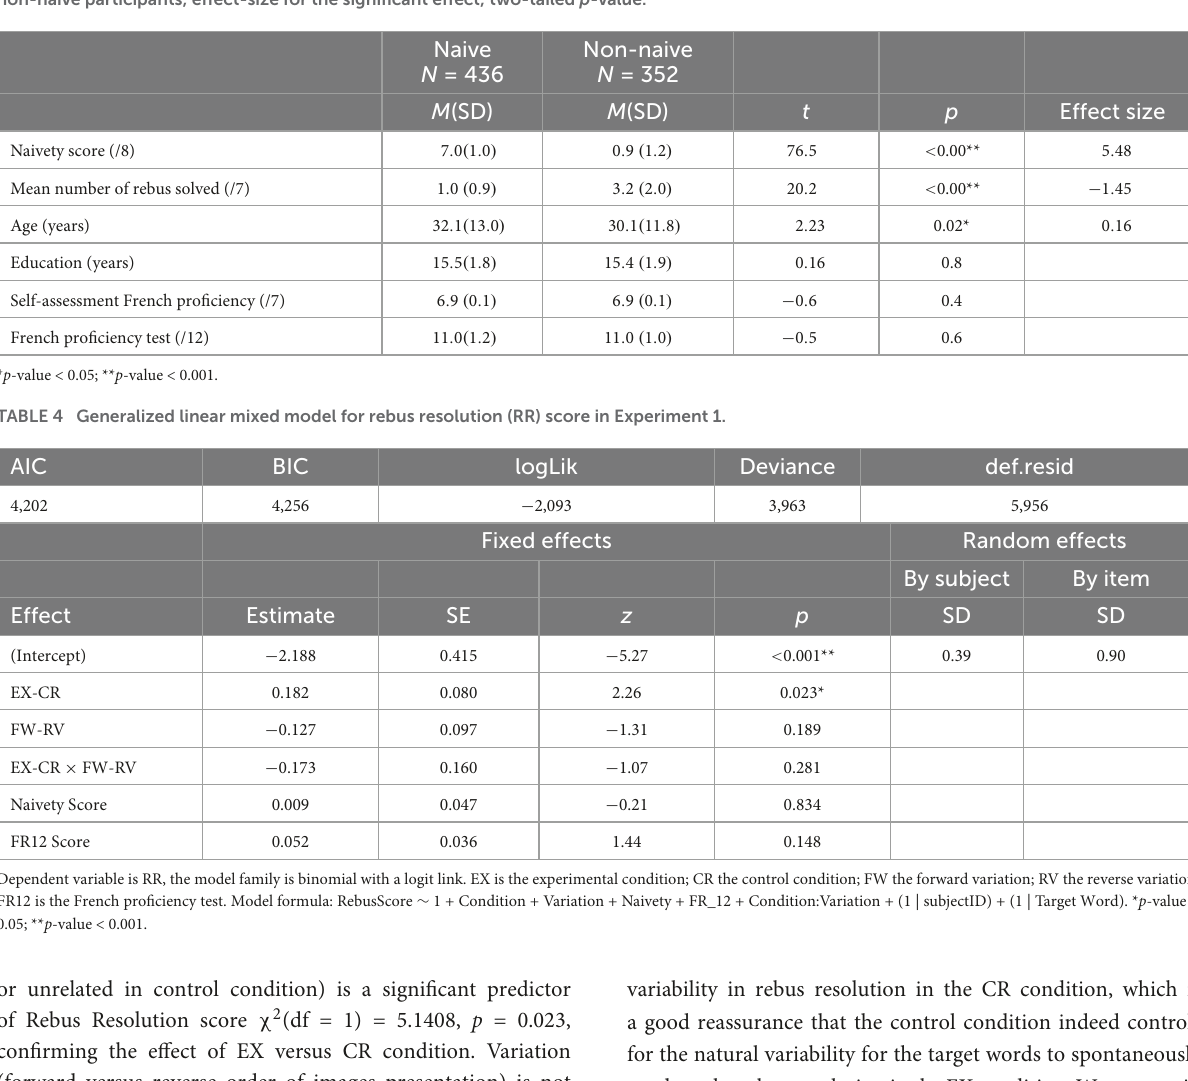
TABLE 3 Mean ( M ) and standard deviation (SD) of the demographic data; t- and p-results on the independent sample T-test between naive and non-naive participants; effect-size for the significant effect; two-tailed p -value.